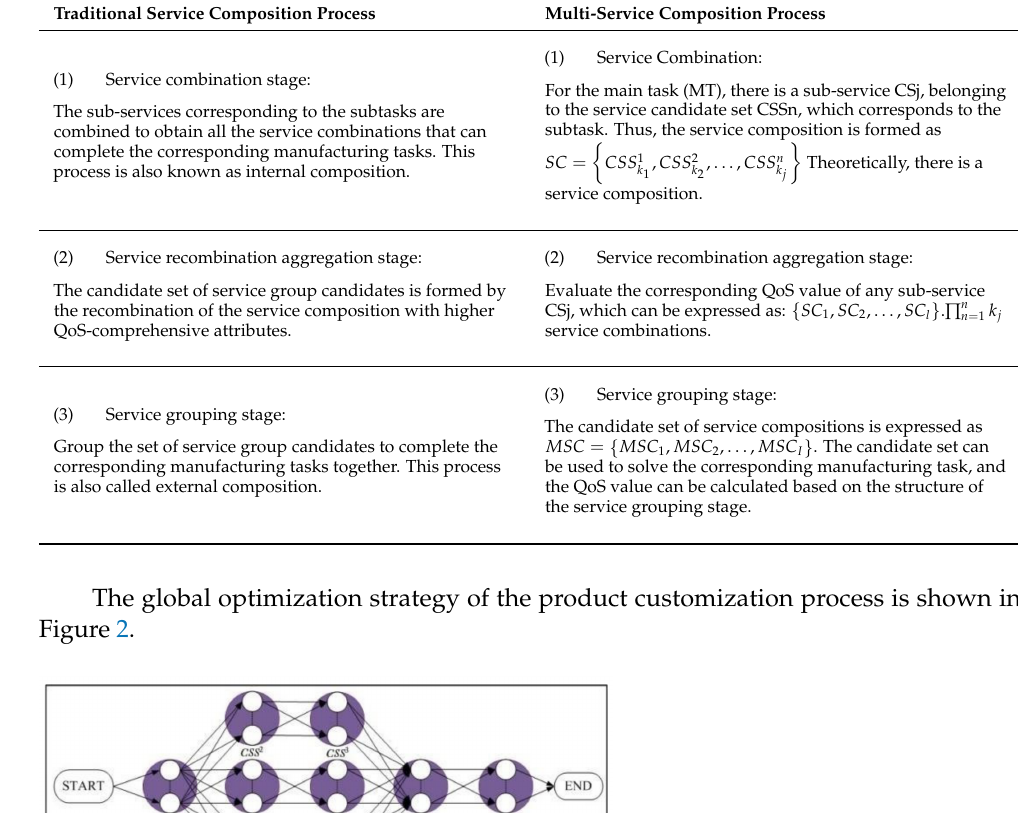
Table 4. Comparison of service combination process.